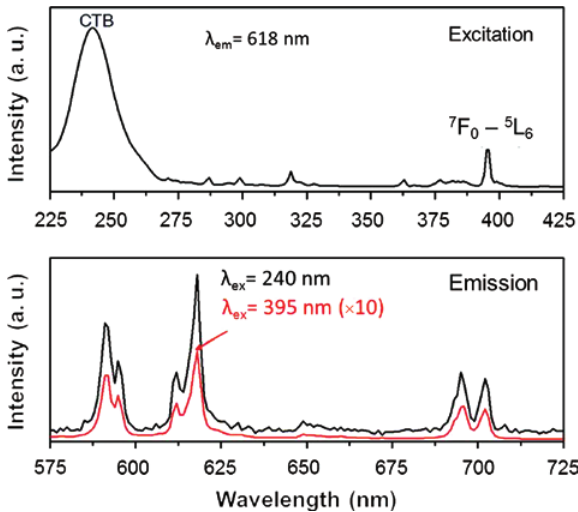
Figure 5: Excitation (top) and emission (bottom) spectra obtained for the Eu Y PO nanophosphor. 0.25 0.75 4 Taken with modifications from [87]. Reproduced with permission of the American Chemical Society. Copyright ©